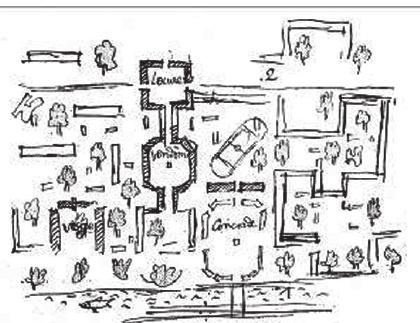
fig. 1. Composition of parisienne squares in sequence with new buildings and green areas. from le Corbusier, le